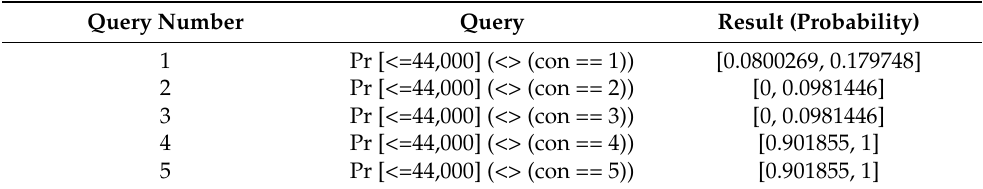
Table 2. Sample queries for estimation of the probability (Pr) of reaching a certain controller state.